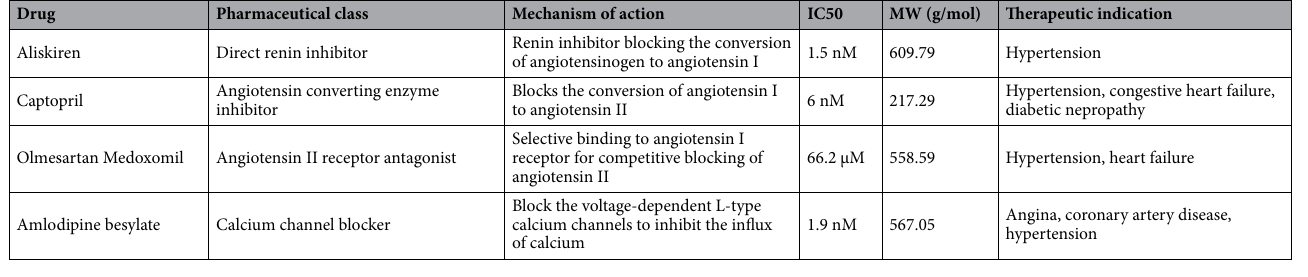
Table 1. Description of the anti-hypertensive drugs evaluated in this study.